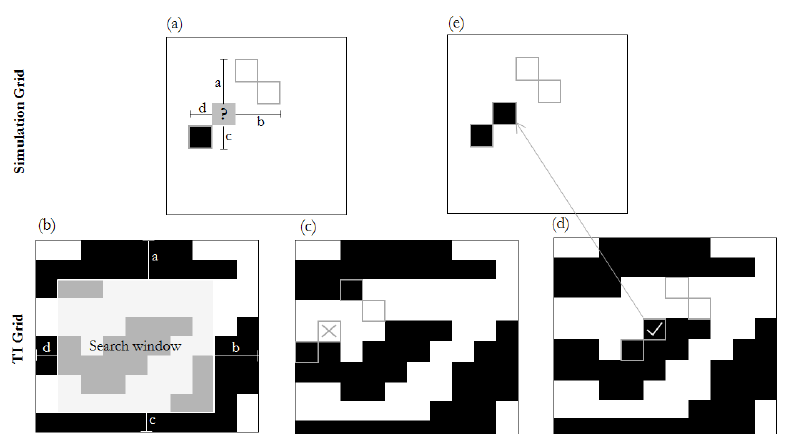
Figure 2. Graphical illustration of DS method. (a) Define the data event in the target image. (b) Define a search window in the TI grid. (c) Scan the TI using the search window until (d) the simulation data event is matched satisfactorily. (e) Assign the value of the central pixel of the first matching data event to the target pixel (Mariethoz et al., 2010) Yaseen et al., (2013), the missing values in the InSAR